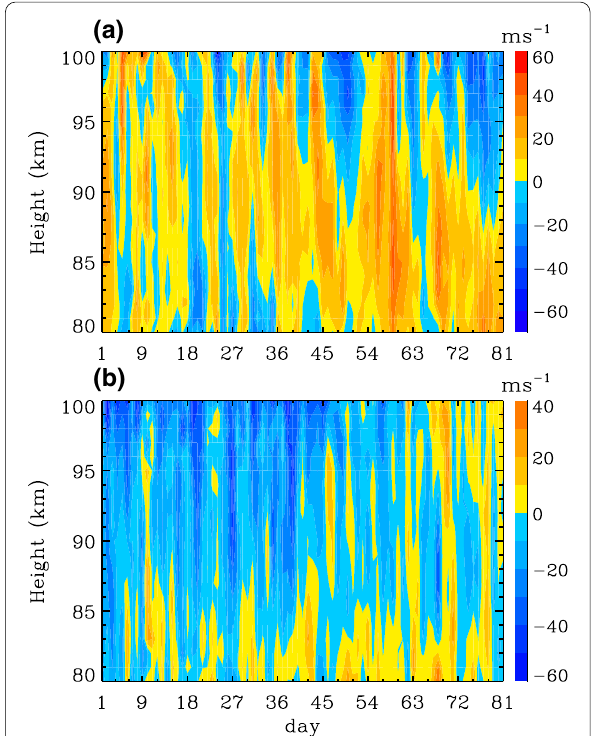
Fig. 1 Daily mean a zonal and b meridional winds from Maui meteor radar observation for 81 days from 12 August to 31 October